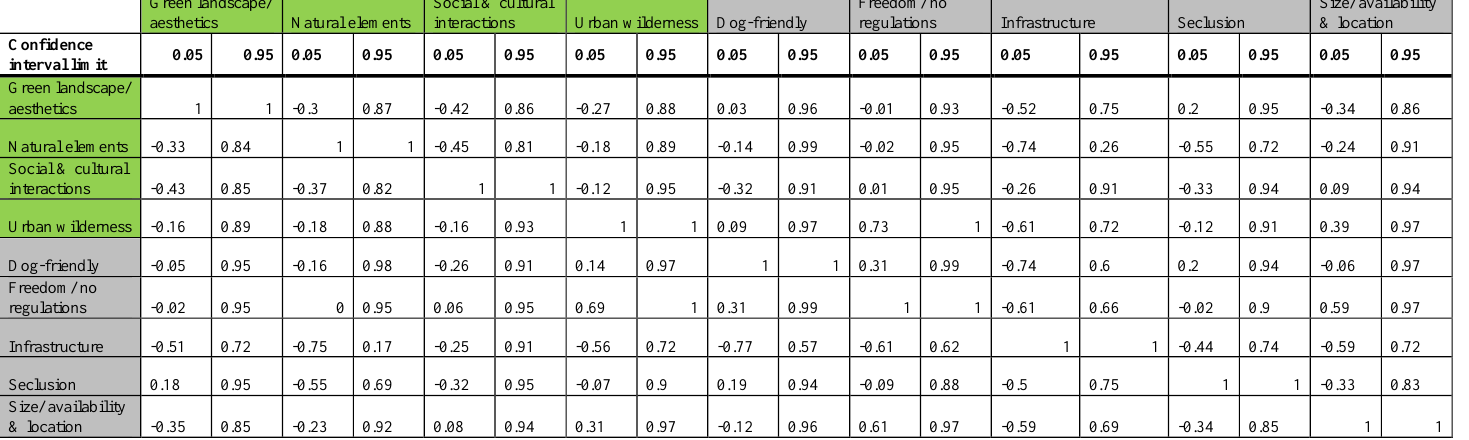
Table A1.5: Lower and upper confidence intervals for 1000 bootstrapped correlation coefficients for weighted Spearman’s rank-correlation of benefits in green brownfields. Confidence intervals that do not include zeros (= are below or above zero) are suggesting significant correlations ( p<0.05